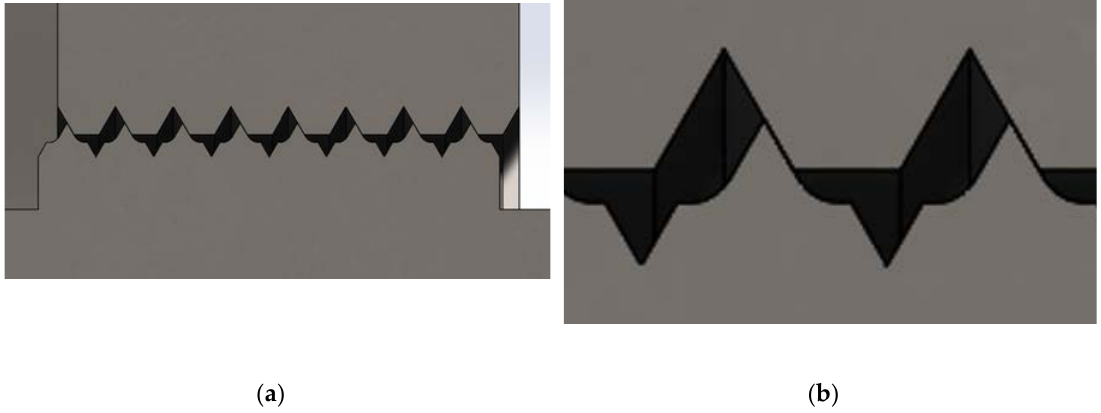
Figure 3. View of a thread contour with modelled shank wear: ( a ) all pitches, ( b ) two pitches magnified.